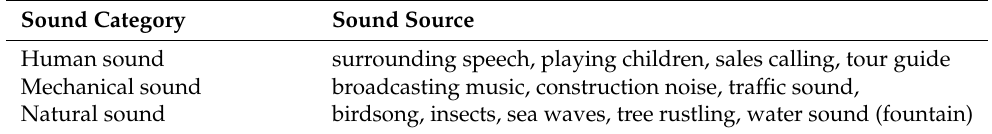
Table 1. Identified sound sources in